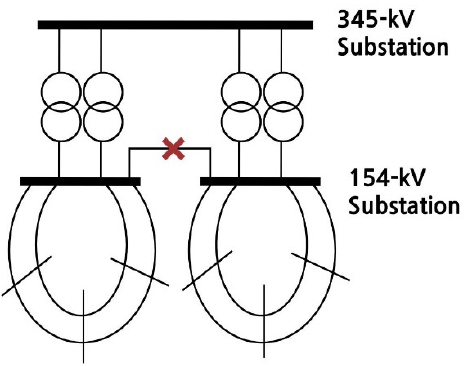
Figure 1. Busbar separation method with a sufficient transformer capacity.